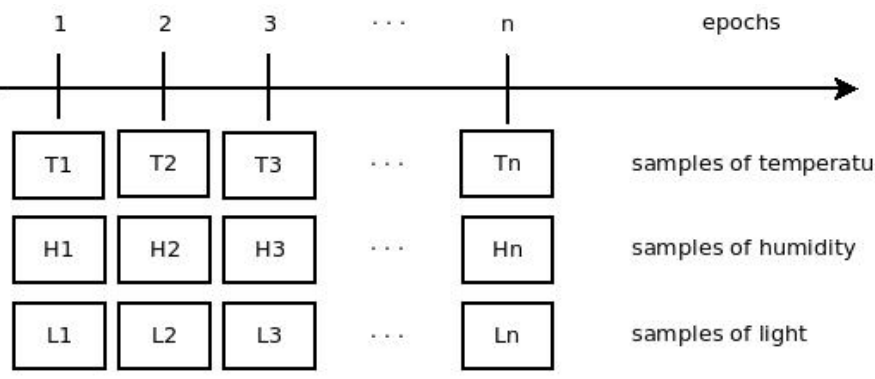
Figure 1. Operation of the monitoring